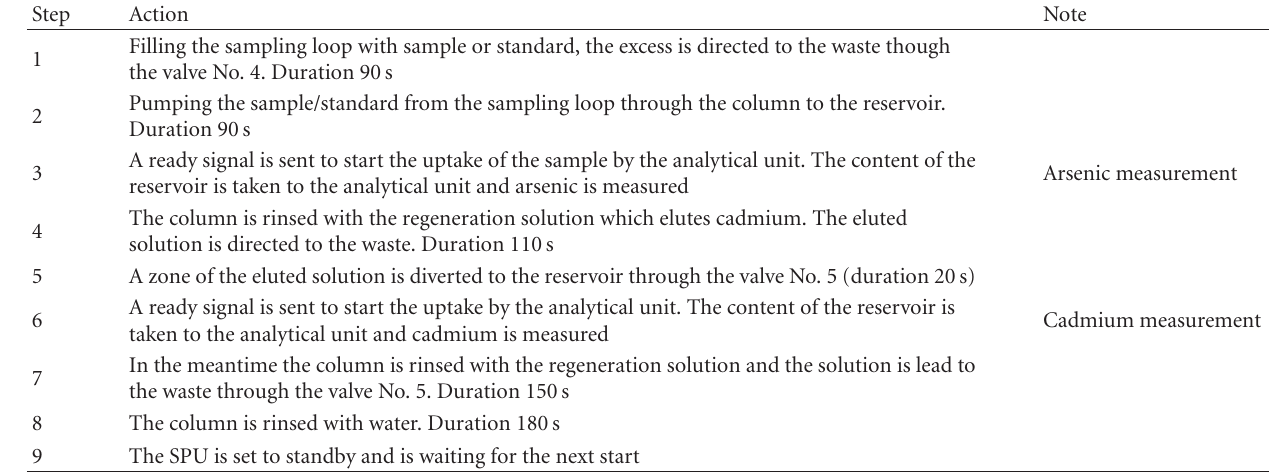
Table 2: Timetable of the separation unit and the measurement